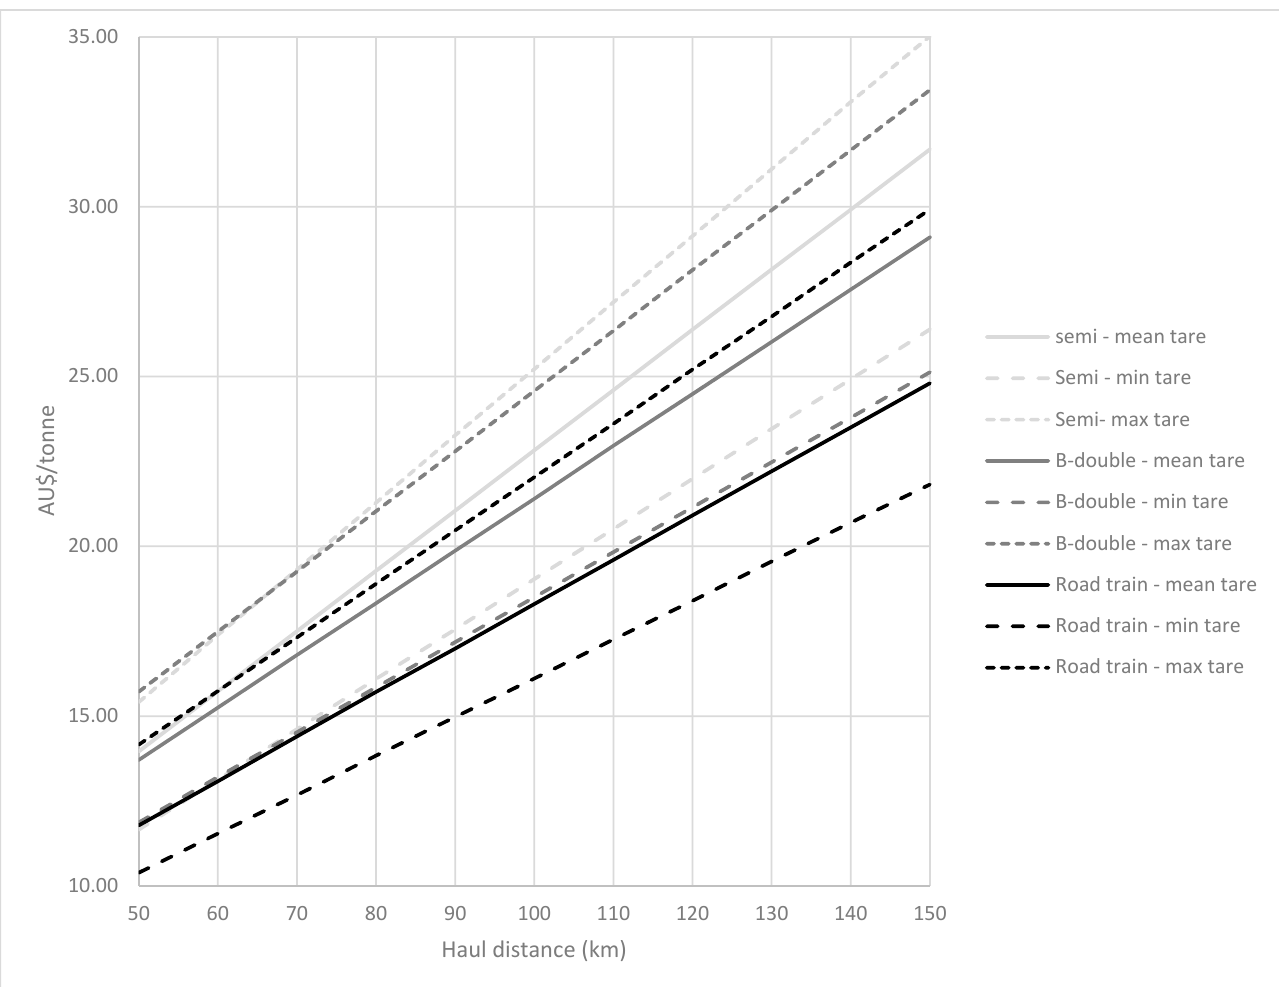
Figure 4 . Indicative transportation costs by transport distance for tare weight and legal GVW recorded .